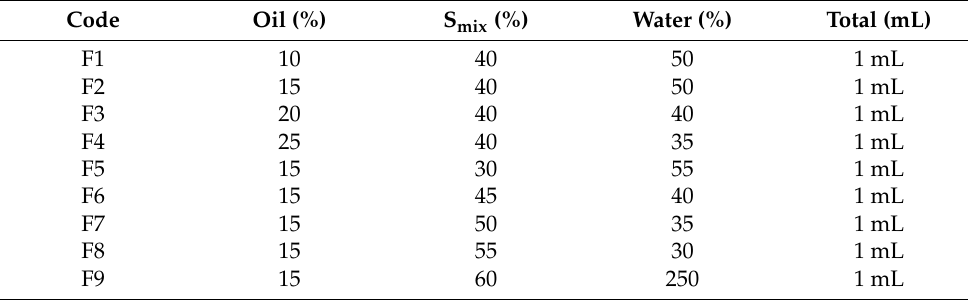
Table 2. Composition of 1 mL APR-SNEDDS each containing 5 mg of the drug.